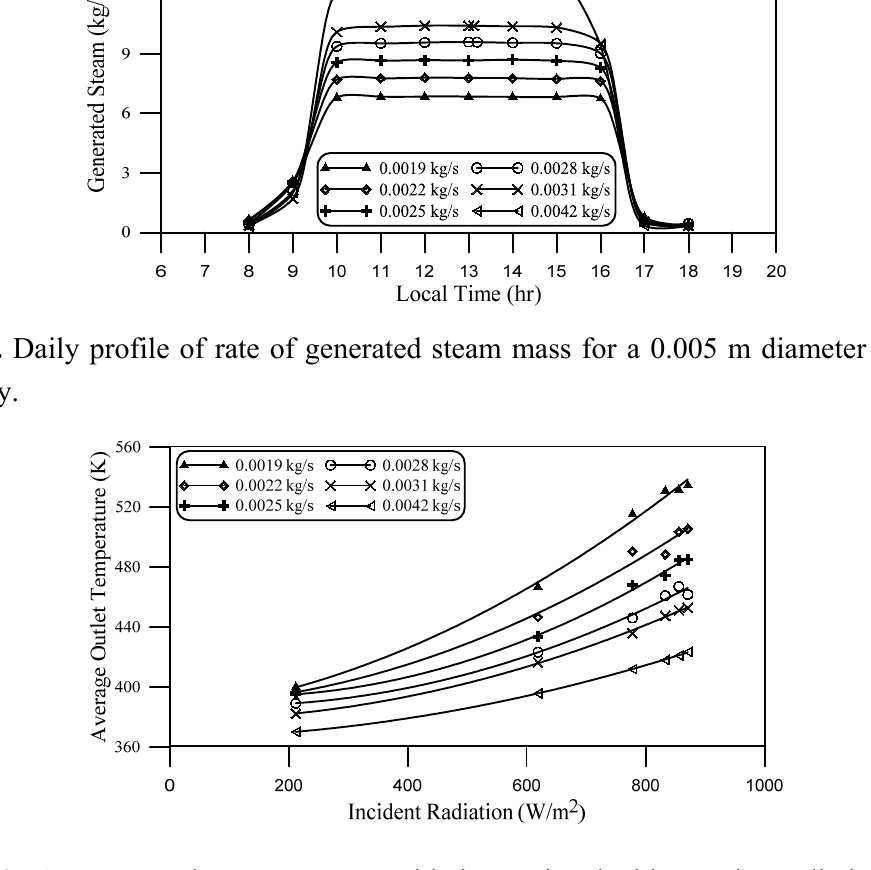
Figure 10. Average outlet temperature with increasing incident solar radiation for the 0.005 m tube in